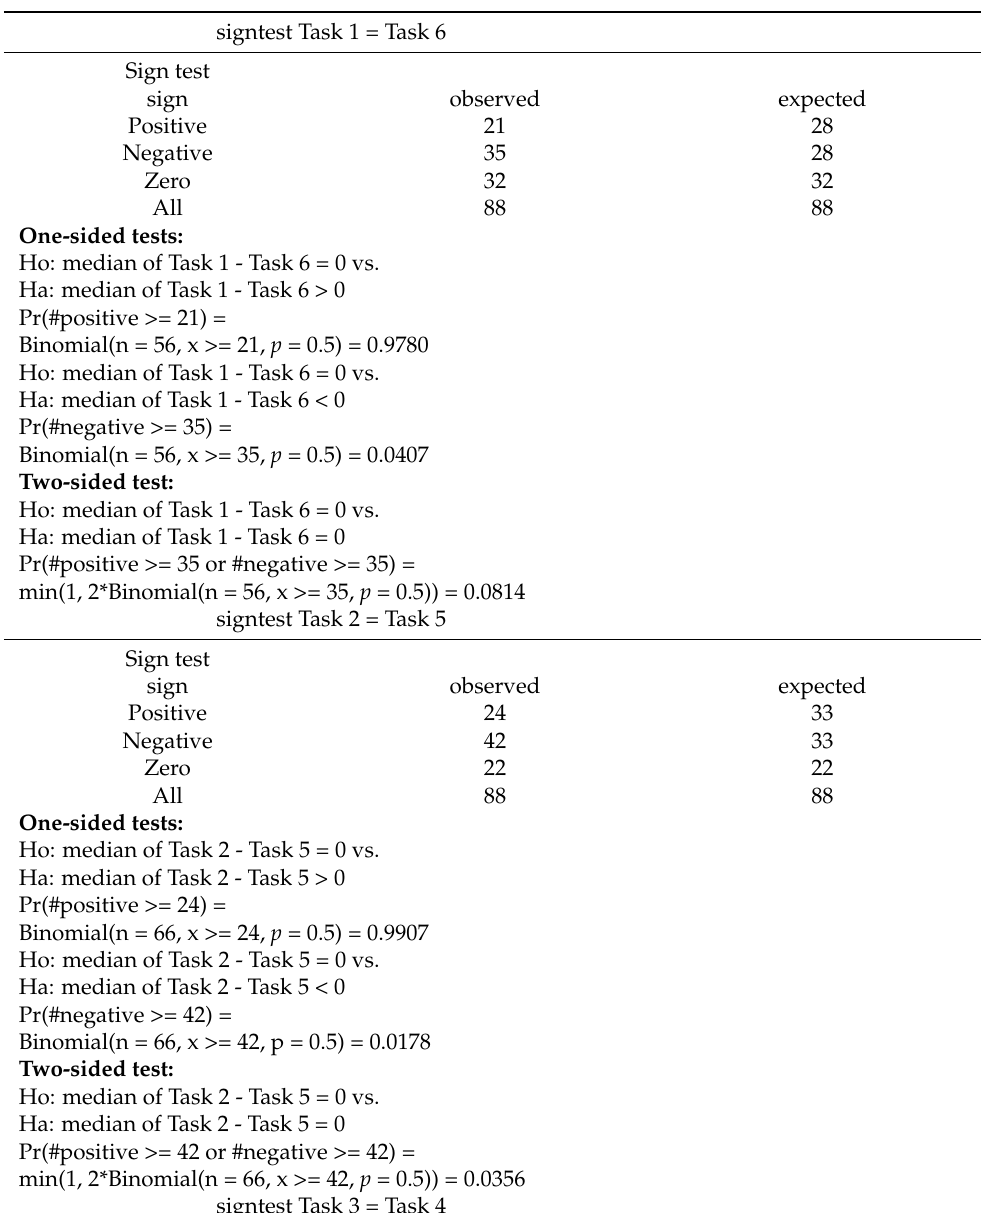
Table A5. Results of the Arbuthnott–Snedecor–Cochran sign